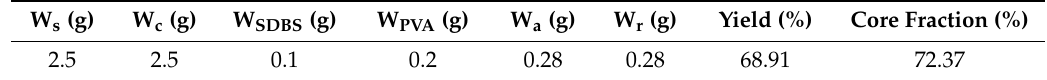
Table 1. Synthesis conditions and main index of the